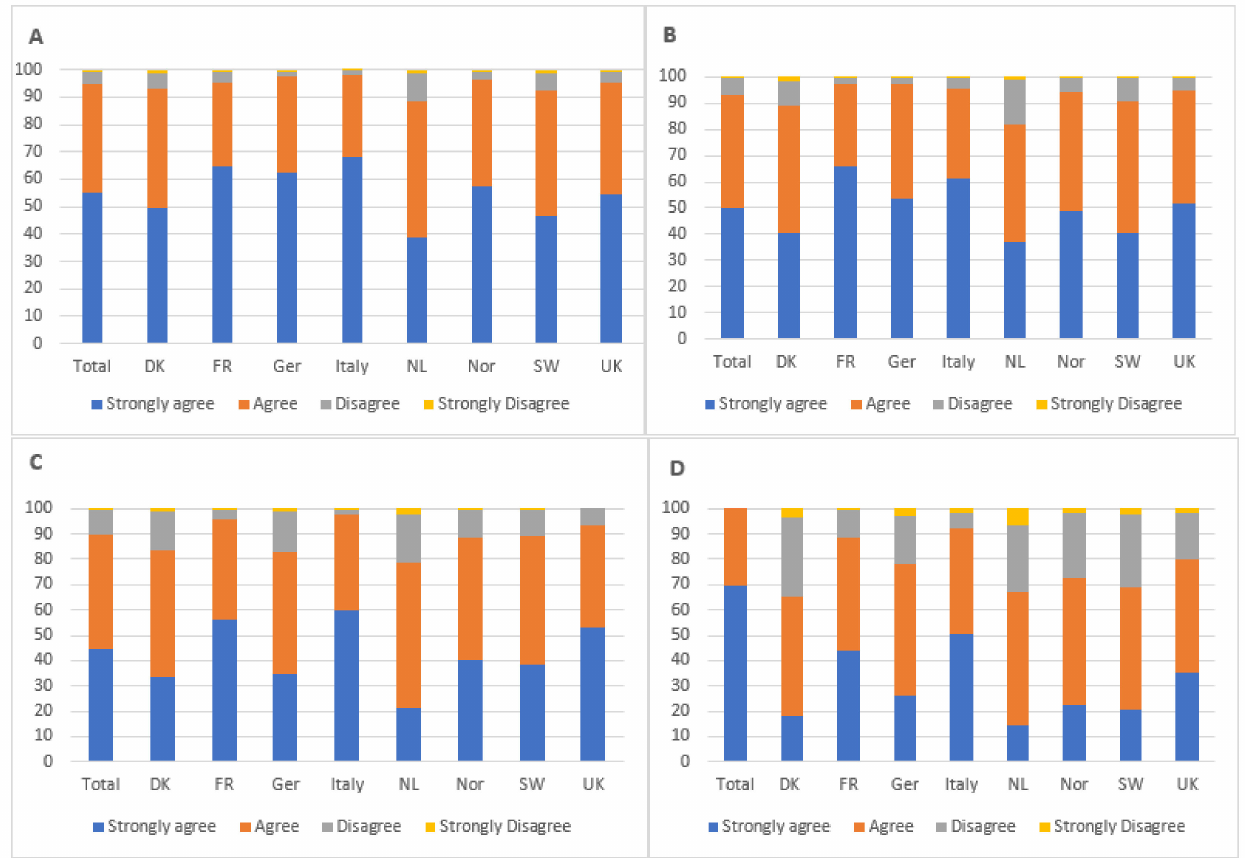
Figure 4. Respondents’ perception of the extent to which their use of mountain bike trails has influenced their attitudes towards nature. ( A ) Increased appreciation of nature. ( B ) Increased willingness to protect trails. ( C ) Taken action to protect nature. ( D ) Changed behaviour to reduce environmental